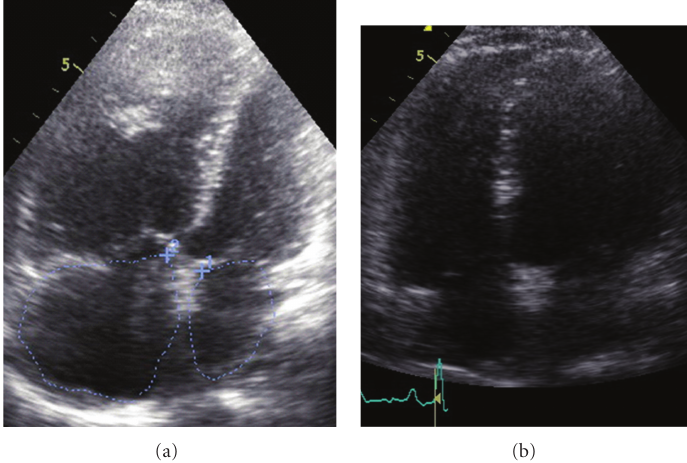
Figure 1: (a) Pulmonary Langerhans cell granulomatosis echocardiography, 4-chamber view, before treatment with sildenafil. (b) Pulmo- nary Langerhans cell granulomatosis echocardiography, 4-chamber view, after treatment with sildenafil.